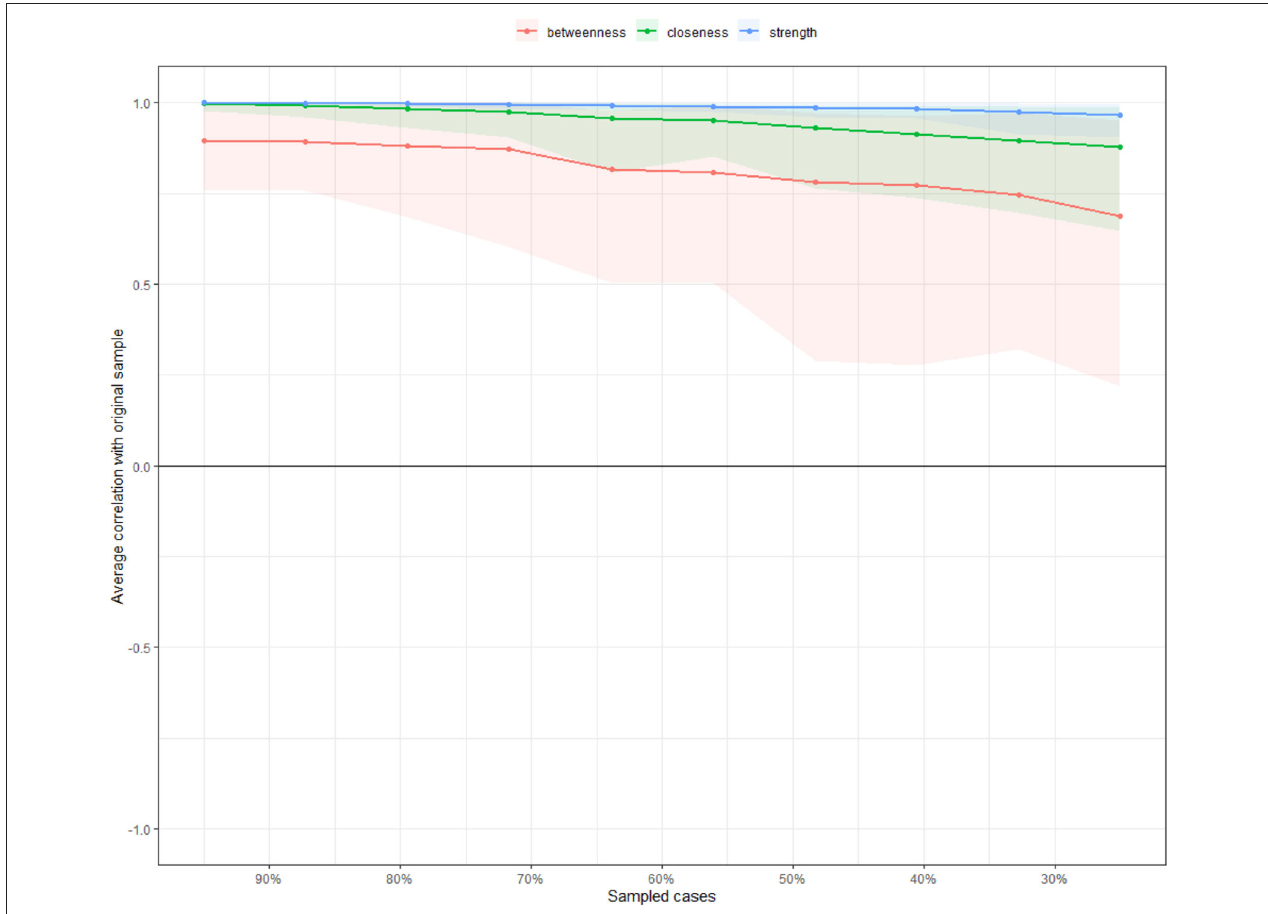
FIGURE 3 | Stability of centrality indices by case dropping subset bootstrap. The x-axis represents the percentage of cases in the original sample used at each step. The y-axis represents the average of correlations between the centrality indices in the original network and the centrality indices in the networks that were re-estimated after dropping increasing percentages of cases. Color areas indicate 95%